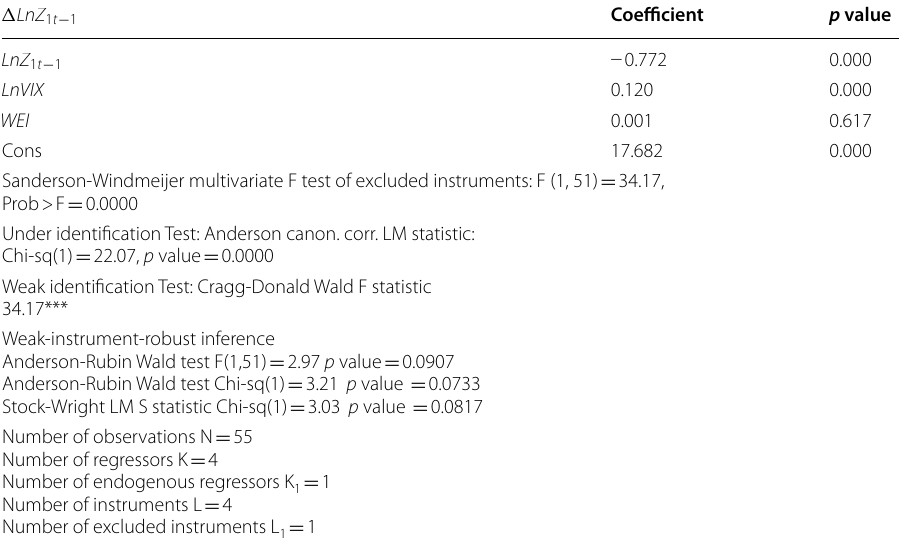
Notes: *** indicate significant at 1% level of significance